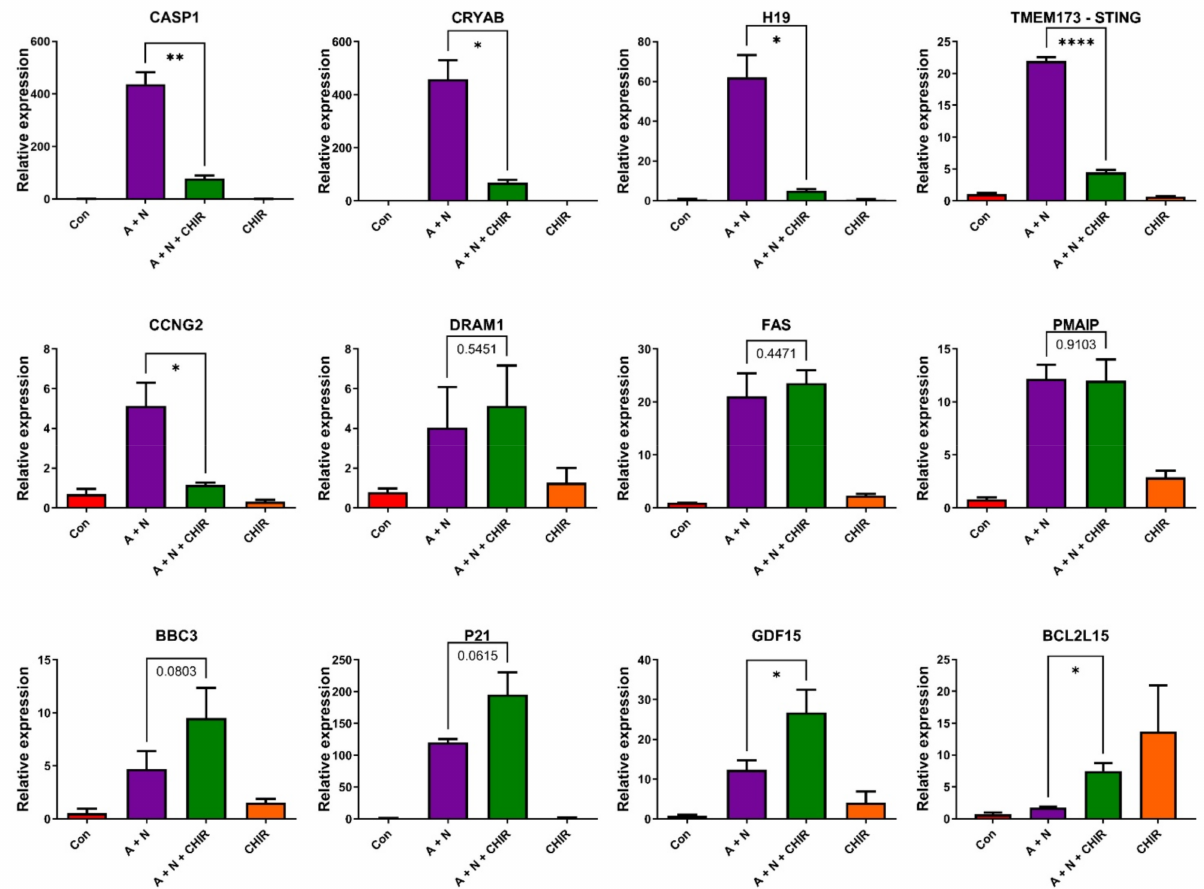
Figure 7. Genes response to the treatment with CHIR-98014 is not uniform. Changes in the levels of mRNAs of indicated genes, measured by semi-quantitative real-time PCR of samples isolated from mock-treated A549 cells (Con) or from cells incubated for 30 h as indicated. The mRNA level in the mock-treated population was defined as 1. The concentration of CHIR-98014 was 1 µ M. Results represent means and standard deviations from three biological replicates. Statistical differences in expression were calculated using unpaired t test with Welch’s correction (* p < 0.05, ** p < 0.01, **** p <